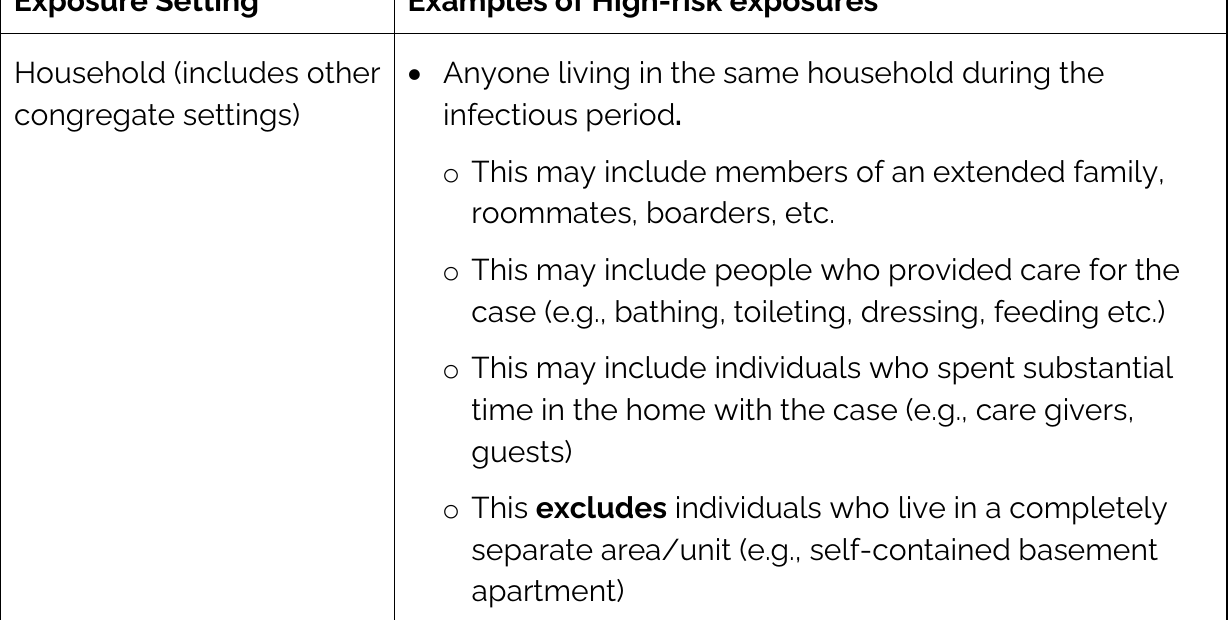
Table 2: Examples of High-Risk Exposures Exposure